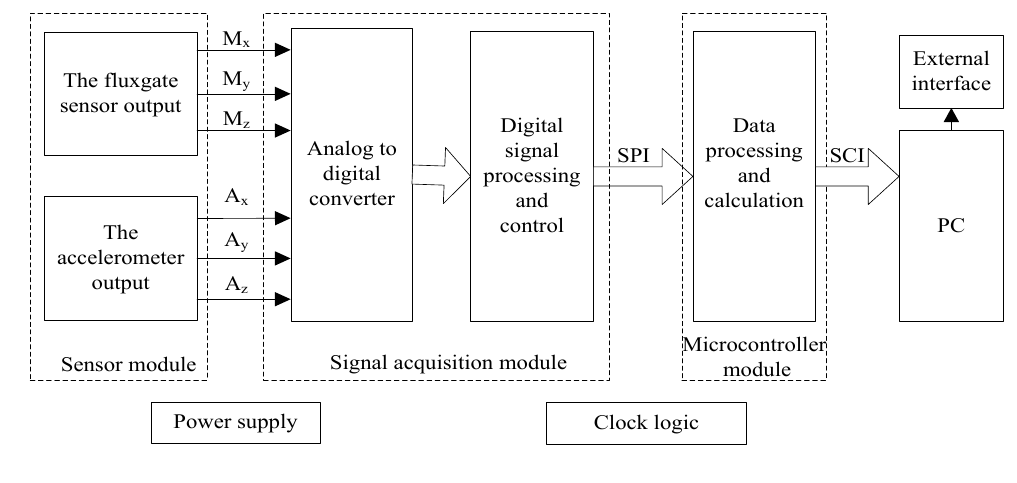
Figure 3. The system principle block diagram.